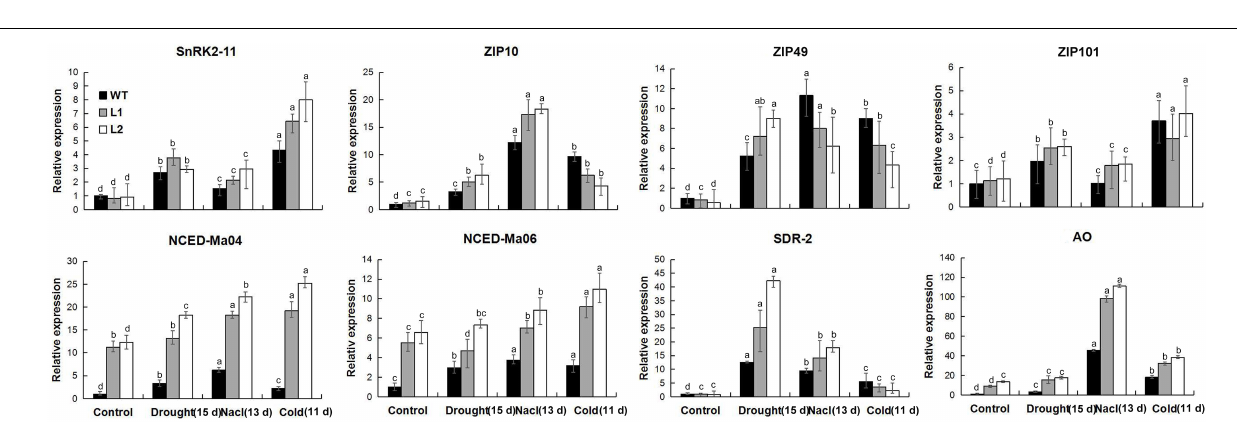
FIGURE 9 | Expression levels of ABA biosynthetic and responsive genes in WT and transgenic lines under normal, drought, cold, and salt conditions. Control means banana seedlings (100-day-old) grow normally. Drought, NaCl, and Cold means, respectively, banana seedlings (100-day-old) were subjected to water withholding for 15 days, salt (250 mM NaCl) for 13 days, and cold (8 ◦ C) for 5 days. Data are means ± SD of n = 3 biological replicates. Means denoted by the same letter are not significantly different at P < 0.05 as determined by Duncan’s multiple-range